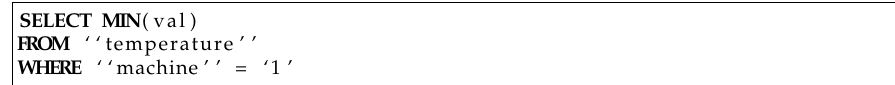
Figure 3. Data retrieval in InfluxDB.